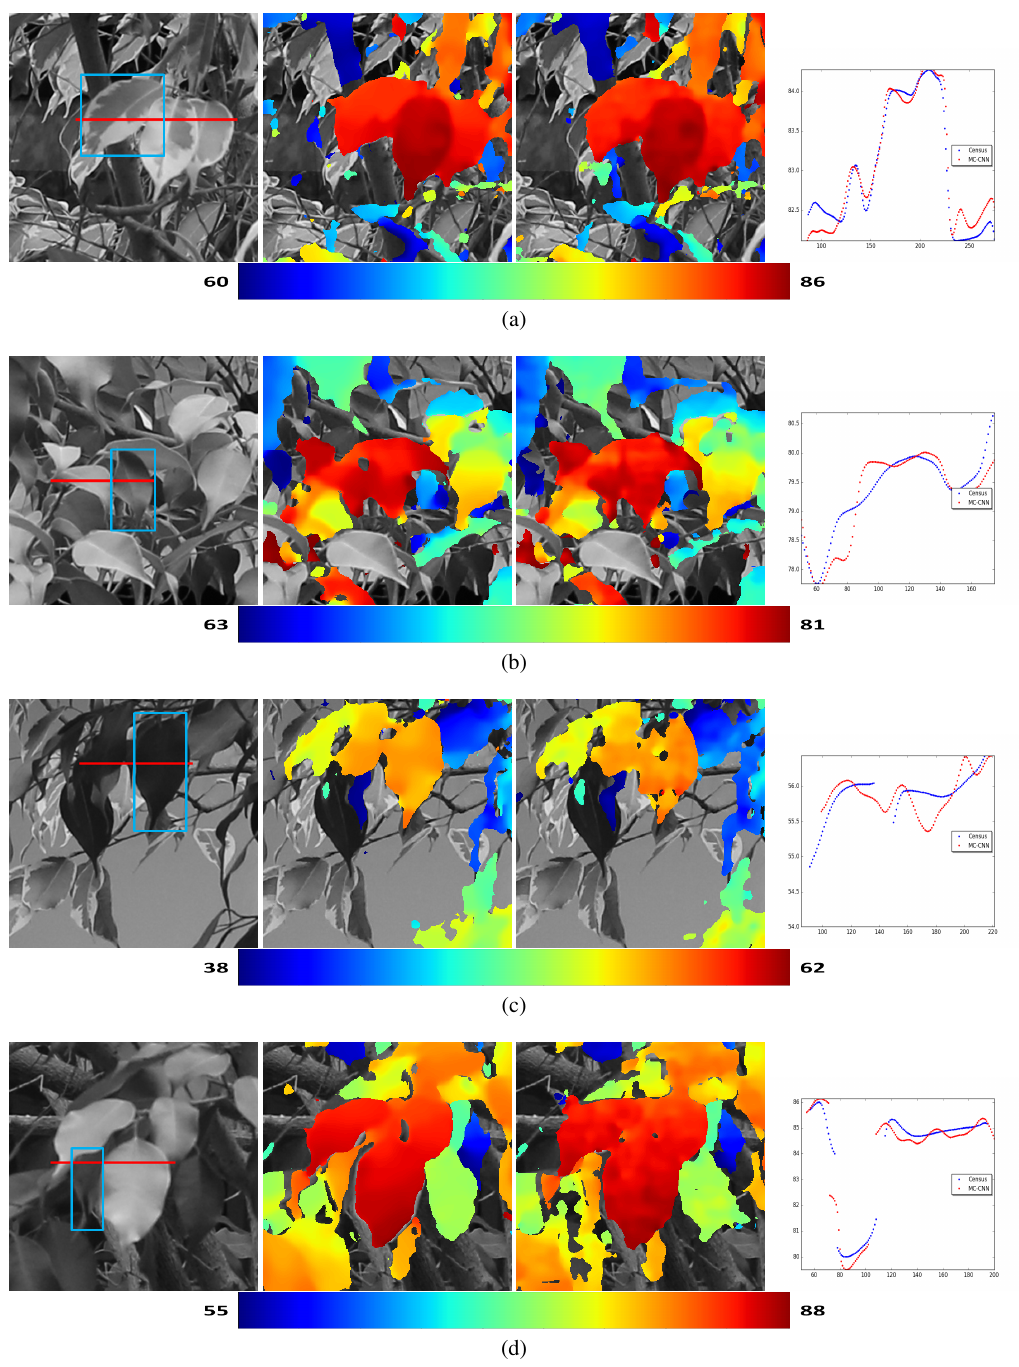
Figure 6. The detailed plant crown comparison. From the left to the right in each subset: the master epipolar image, Census results, MC-CNN results, and the disparity change for one selected line assigned one unified high value on the new maps as a mark of in- valid matching. The rest are naturally regarded as valid